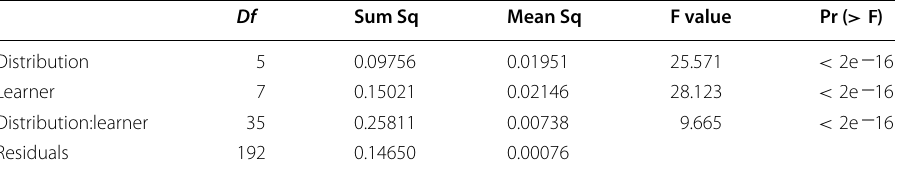
Table 3 ANOVA Results